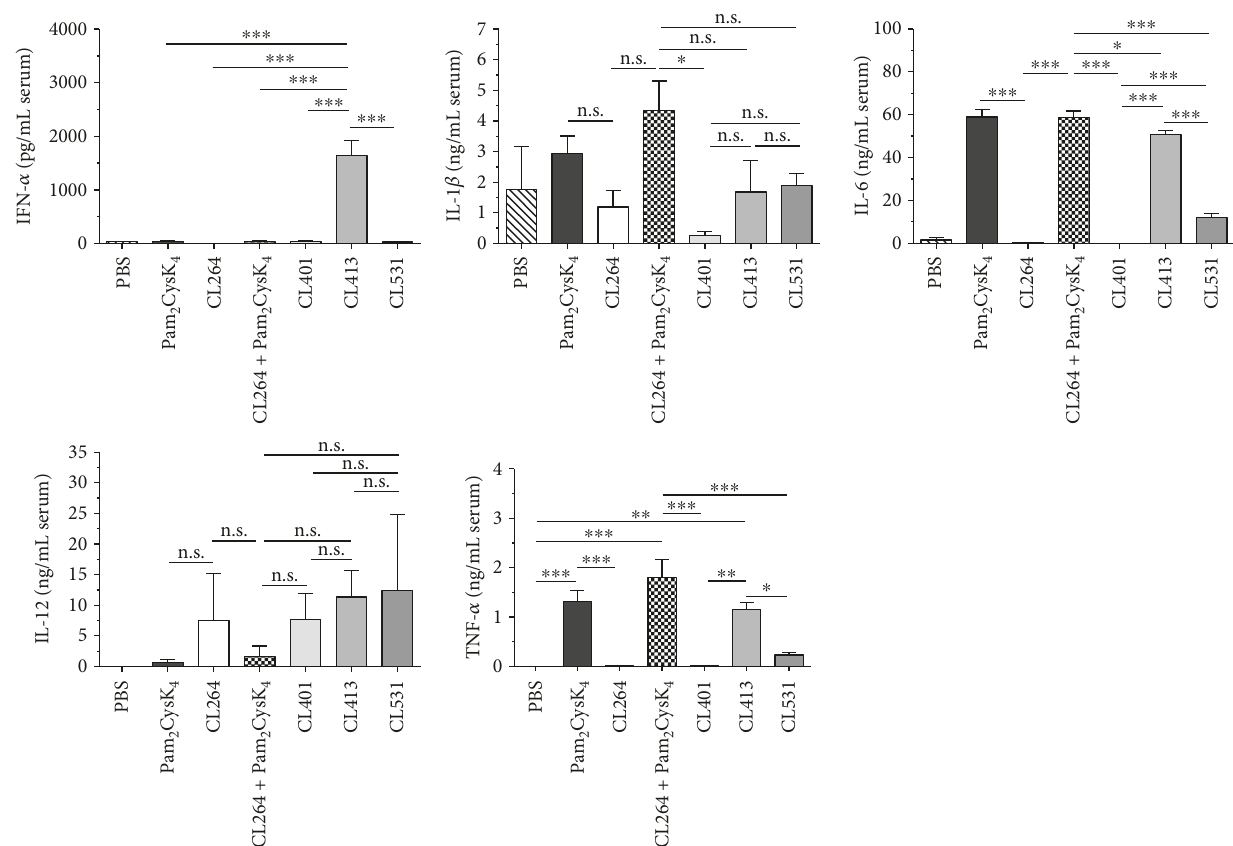
Figure 4: Dual TLR2/7 ligands induce both TLR2- and TLR7-mediated cytokine secretion in vivo . Serum cytokine levels 8 h post i.p. application of 0.2mM of the indicated ligands. Data are mean results of 5 mice per group ± SD. ∗ P < 0 05 ; ∗∗ P < 0 01 ; ∗∗∗ P < 0 001